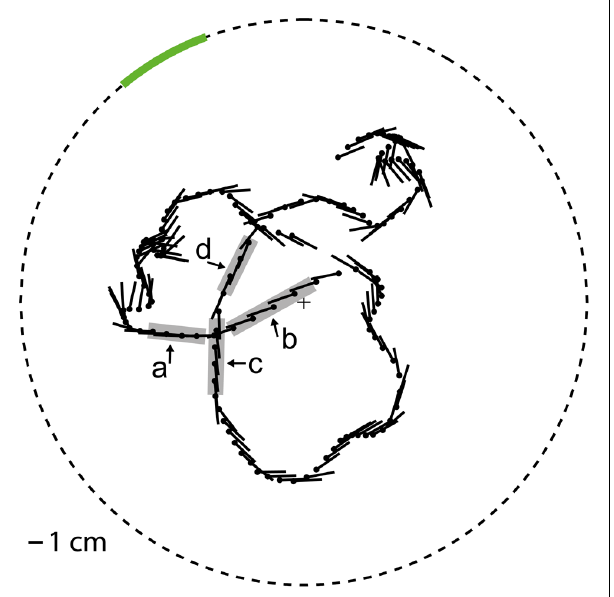
FIGURE 1 |Virtual flight arenaThe object area (green line) is embedded in the cylindrical wall (dashed circle). The position (black dot) and yaw orientation (black line, pointing to the abdomen) of (radius 0.2 m), top view. the fly head is plotted every 25 ms on the flight trajectory.The object response intervals (gray, intervals a–d) are marked at the